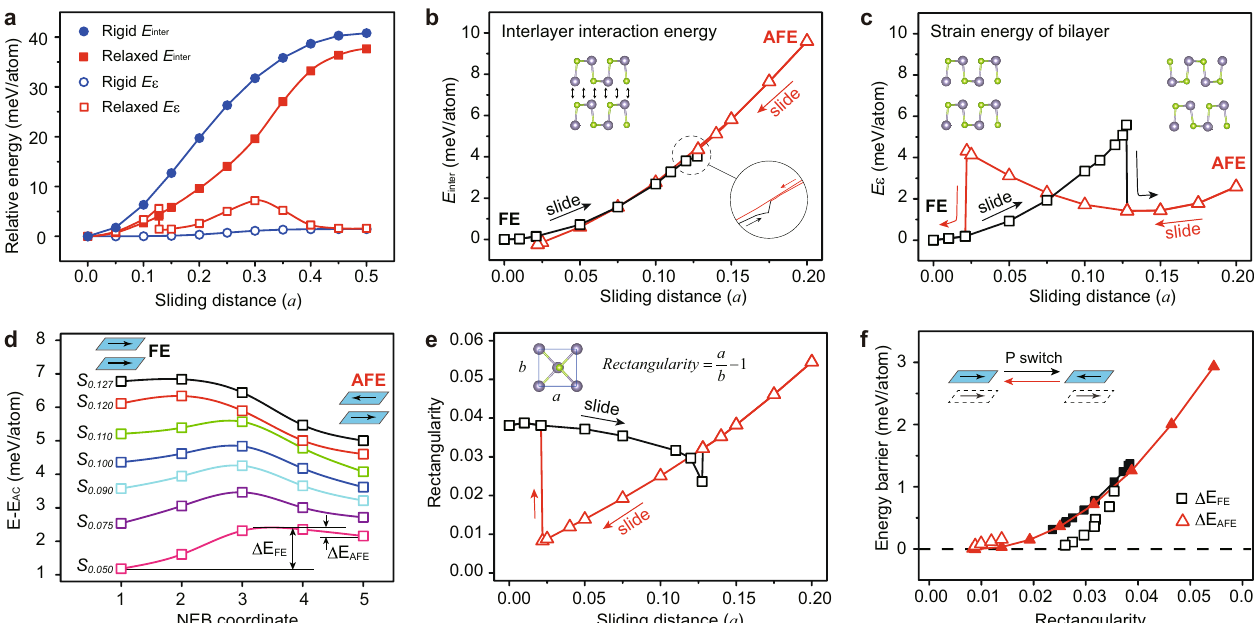
Fig. 3 Physical origin of the spontaneous FE-to-AFE phenomenon. a Comparison of E inter / E ε of the relaxed and rigid bilayer SnSe upon mechanical sliding of the top layer. The signi fi cant interlayer energy E inter reduction dominates over the lattice strain energy increase in the relaxed SnSe bilayer, thus driving the lattice distortion. b E inter and c E ε of the relaxed bilayer SnSe upon mechanical sliding from AC FE to AD AFE . As the sliding distance from AC FE increases, E ε increases and exhibits a sudden drop at the FE-to-AFE transition. In the reverse sliding process, E ε fi rst decreases and then increases before suddenly dropping at the AFE-to-FE transition. The change of E ε is consistent with that of E tot with a similar magnitude, indicating that the strain energy change is the origin for the observed spontaneous FE-to-AFE effect in bilayer SnSe. A similar conclusion can also be drawn for bilayer SnS. d Calculated energy barrier between the FE and AFE states of bilayer SnSe for different sliding positions along the pathway from AC FE to AD AFE . S 0.050 denotes sliding at the position x = 0.05 a . The energy barrier gradually vanishes. At a sliding distance of 0.09 a (i.e., S 0.09 ), the FE state has a higher total energy than the AFE state, but an energy barrier still exists. e Variation of the unit cell rectangularity of bilayer SnSe during the sliding process from AC FE to AD AFE . The spontaneous phase transition takes place at minimum values of the rectangularity, suggesting the correlation. f The phase transition energy barrier depends on the unit cell rectangularity for both bilayer SnSe and monolayer SnSe. Upon reducing the rectangularity, the energy barrier decreases and eventually disappears. The agreement between bilayer and monolayer SnSe indicates that the sliding-induced lattice distortion plays a primary role in the energy